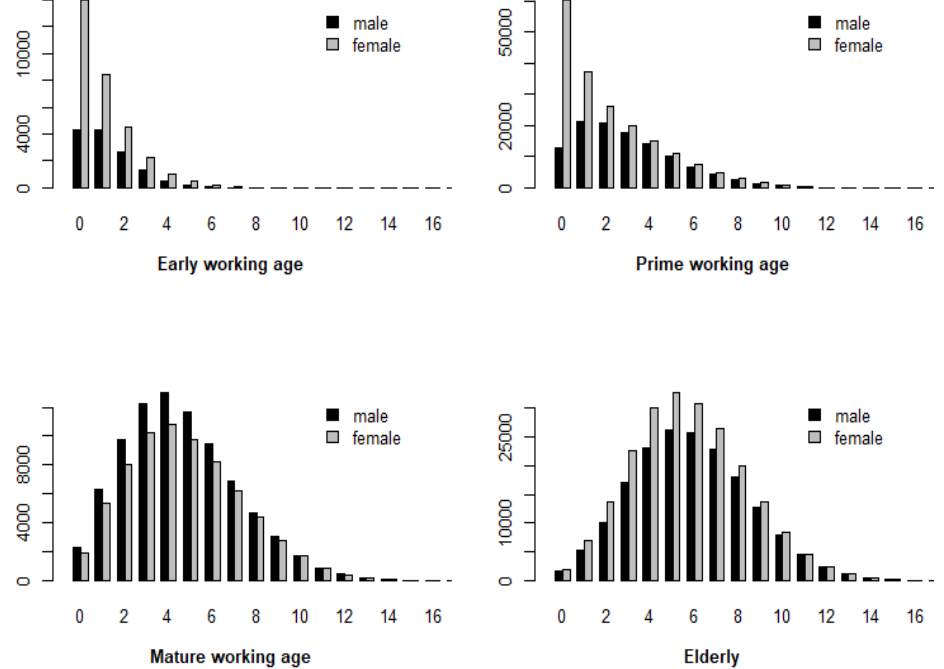
Figure 1. Prevalence of chronic conditions (CC) in patients. The horizontal axis shows the number chronic conditions, and the vertical axis shows the corresponding of chronic conditions, and the vertical axis shows the corresponding counts.